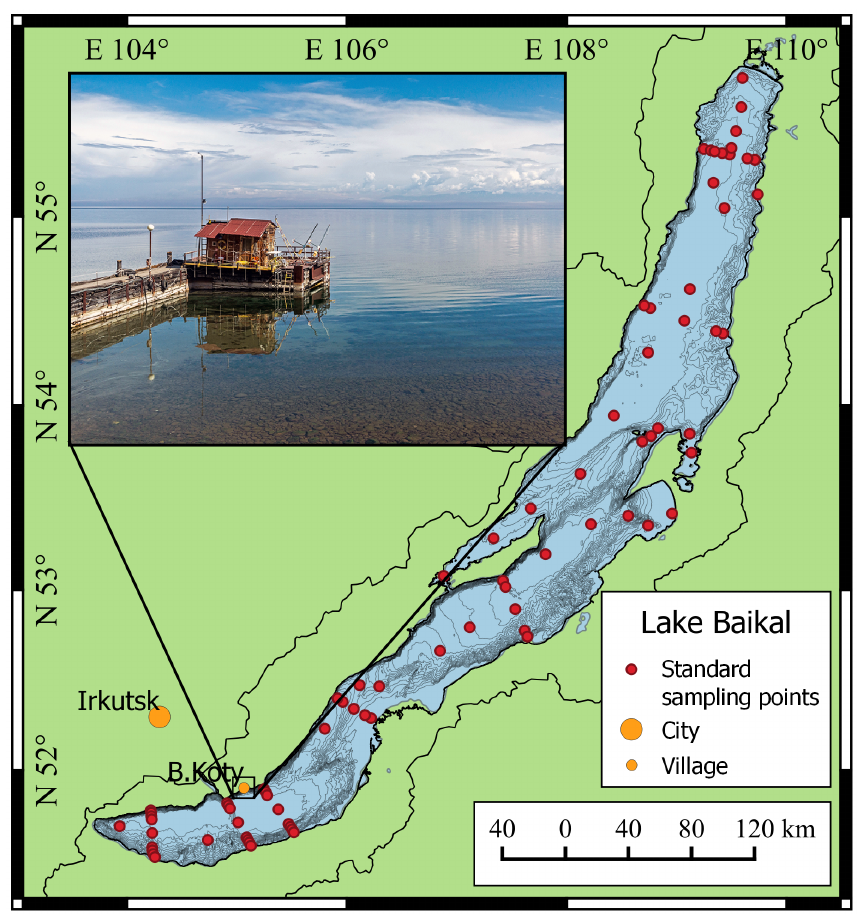
Figure 1. Lake Baikal and the position of the research station of Limnological Institute SB RAS. Red dots—location of standard sampling